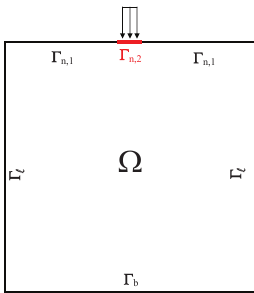
Figure 10. Computational domain for the two-dimensional numerical experiment. At the base of this domain the soil is assumed to be fixed, i.e. both hor- izontal and vertical components of displacements are taken as zero, while at some centered upper part of the domain a uniform load is applied in a strip of length 1 m as depicted in Figure